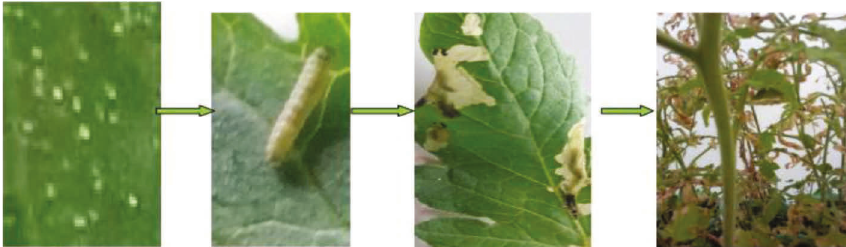
Figure 2: Feeding style and damage status of the tomato leafminer, Tuta absoluta